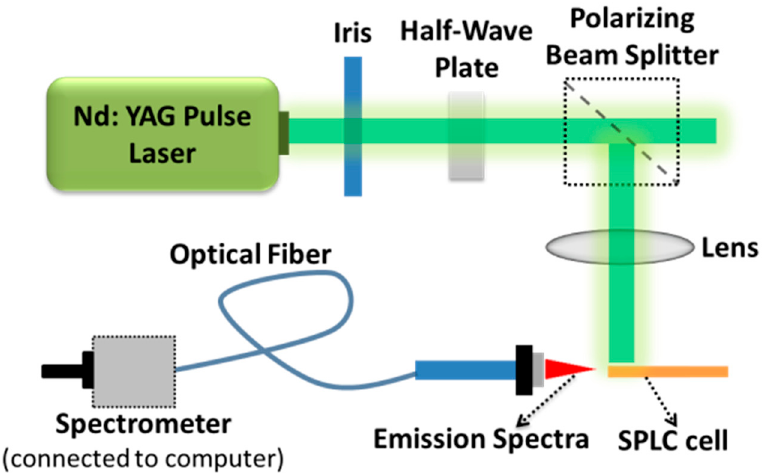
Figure 5. Experimental setup used to investigate laser action in dye-doped templated SPLC.